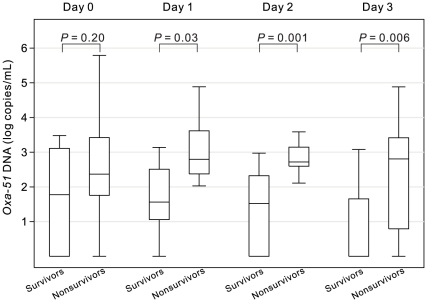
Initial Oxa-51 DNA load from day 0 to day 3 in patients with A. baumannii bacteremia (34 nonsurvivors, 17 survivors).Data are presented as median (line), interquartile range (box) and range.